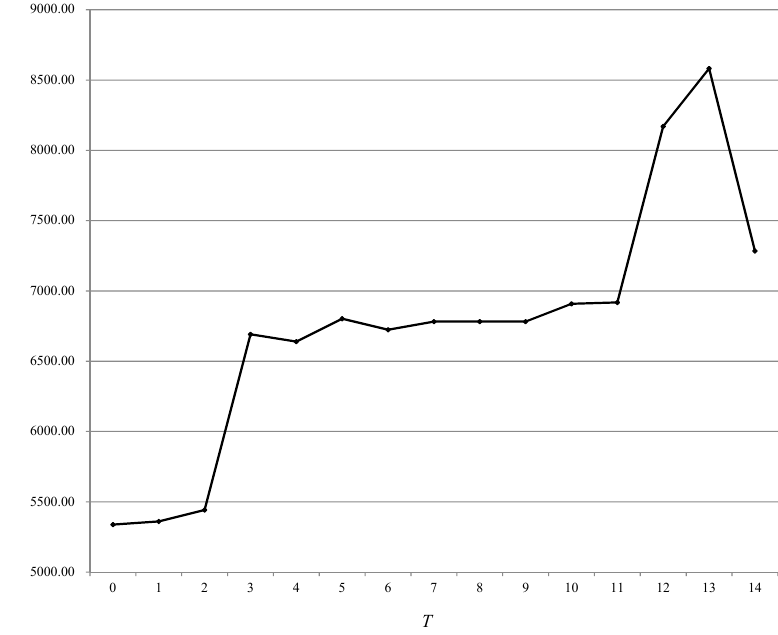
Figure 6. Overall errors of change detection using different multi-scale fusion thresholds, with L1 as the basis image in the first study area.